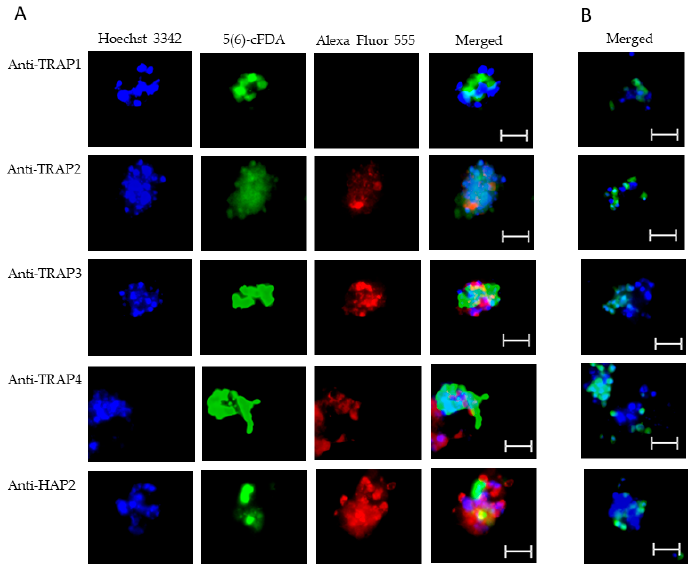
Figure 6. Evaluation of surface expression of TRAP proteins by B. bovis sexual stages using a live immunofluorescence assay incubated with anti-TRAP 1, 2, 3, 4, or HAP2. Panels are ( A ) immune and ( B ) pre-immune rabbit serum. Blue indicates Hoechst 33342 stained DNA, green indicates live, intact exoerythrocytic parasites retaining 5(6)-cFDA, and red indicates anti-rabbit IgG Alexa Fluor 555 reactivity. Scale bar: 5 µm.